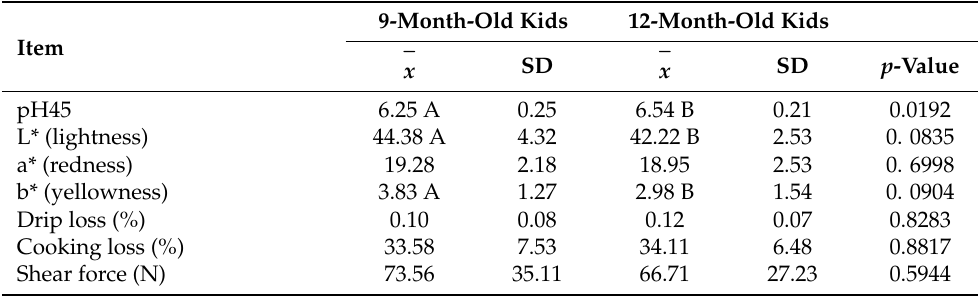
Table 3. Physicochemical properties of kid’s